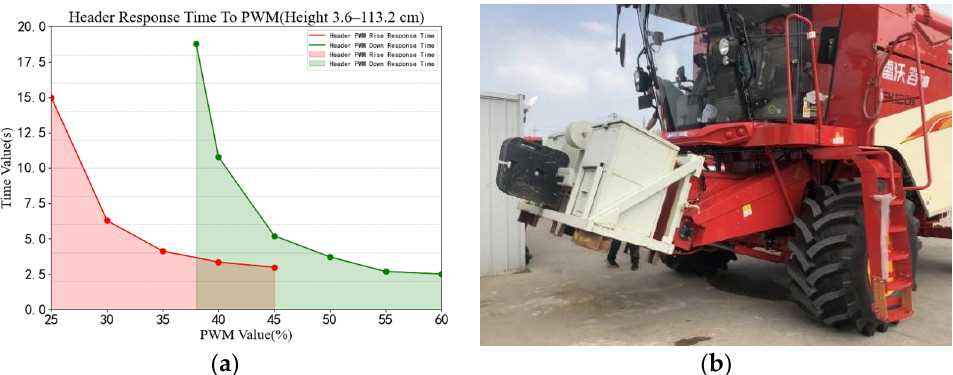
Figure 11. Influence of different PWM values on the lifting effect of the header. ( a ) Header re- sponse curve; ( b ) Field test chart.